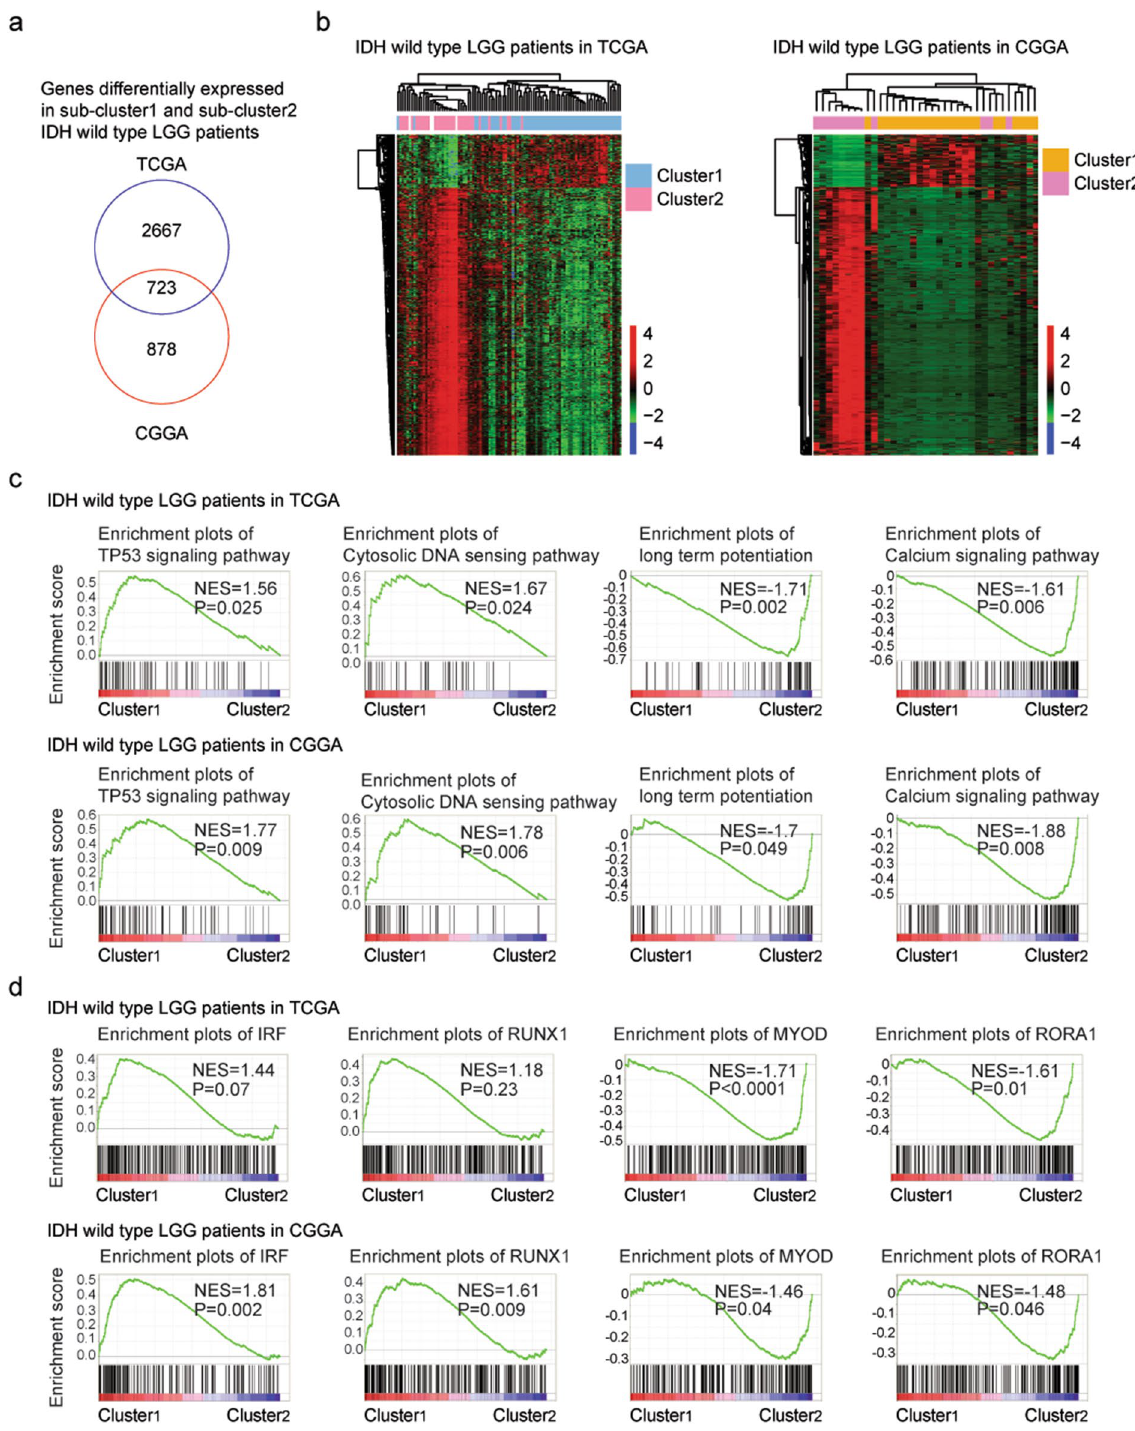
Figure 2. Transcriptional characteristics of the different sub-clusters of IDH wild type LGG patients. ( a ) Overlapping the differentially expressed genes between sub-cluster1 and sub-cluster2 IDH wild type LGG patients in TCGA and CGGA datasets. ( b ) Un-supervised clustering heatmaps demonstrated the common differentially expressed genes between sub-cluster1 and sub-cluster2 IDH wild type LGG patients in TCGA and CGGA datasets. Red represented the up-regulated genes and blue represented the down-regulated genes. ( c ) Enrichment plots showed the enriched signaling pathways in different sub-clusters of IDH wild type LGG patients in TCGA and CGGA datasets. ( d ) Enriched transcription factors in different sub-clusters of IDH wild type LGG patients in TCGA and CGGA datasets. ( e ) Enrichment plots of RUNX1 transcription factor in different stromal score and immune score IDH wild type LGG patients in TCGA and CGGA